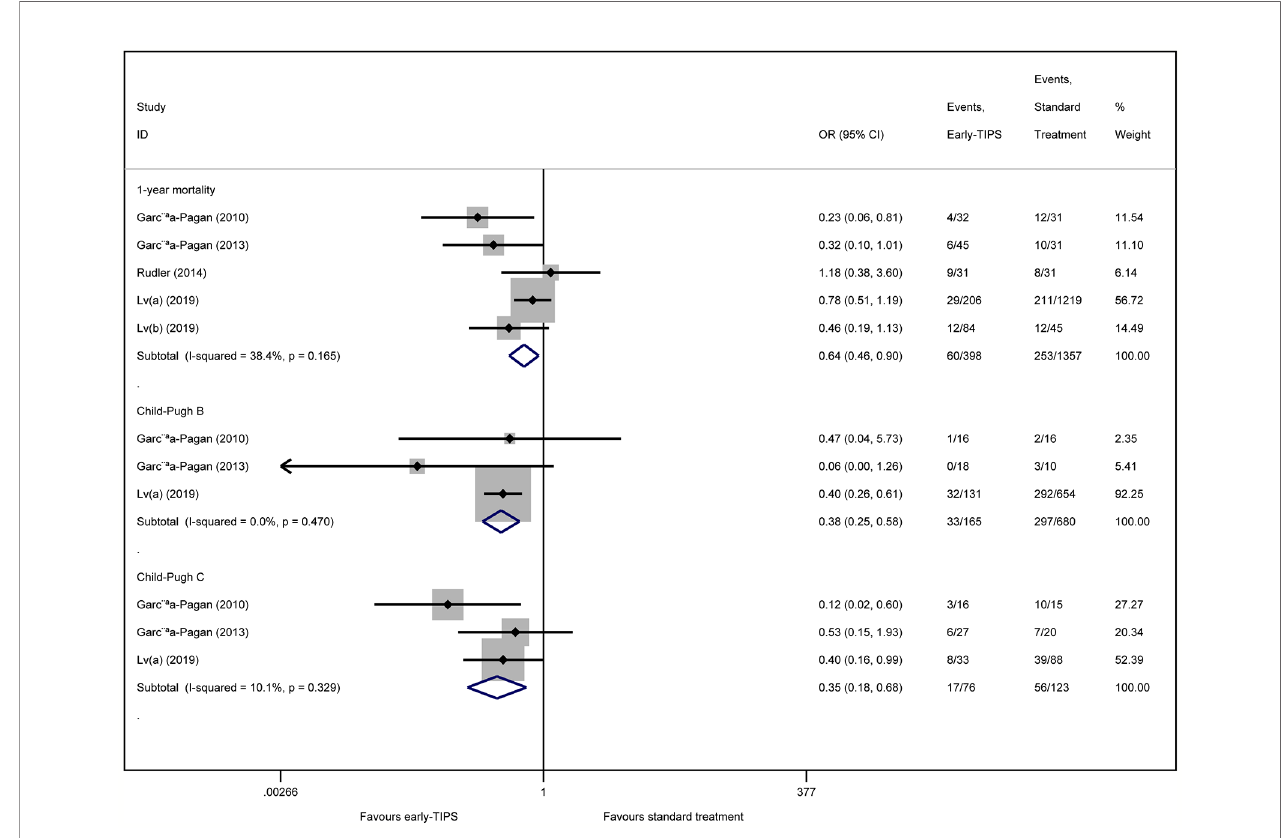
FIGURE 3 | Forest plot demonstrating long-term mortality (1-year) and subgroup analysis according to Child-Pugh